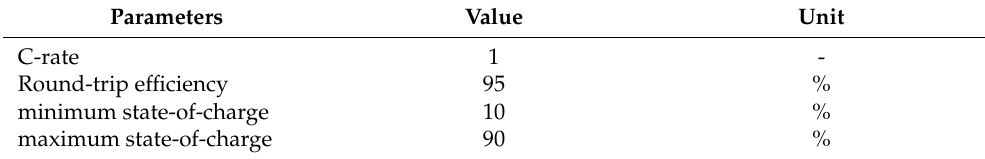
Table A9. BESS parameters.